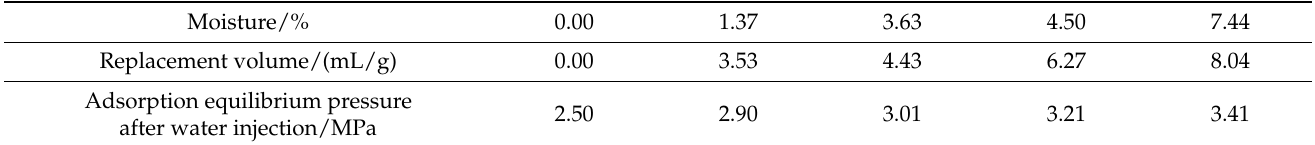
Table 2. Gas displacement amounts at adsorption equilibrium pressure of 2.5